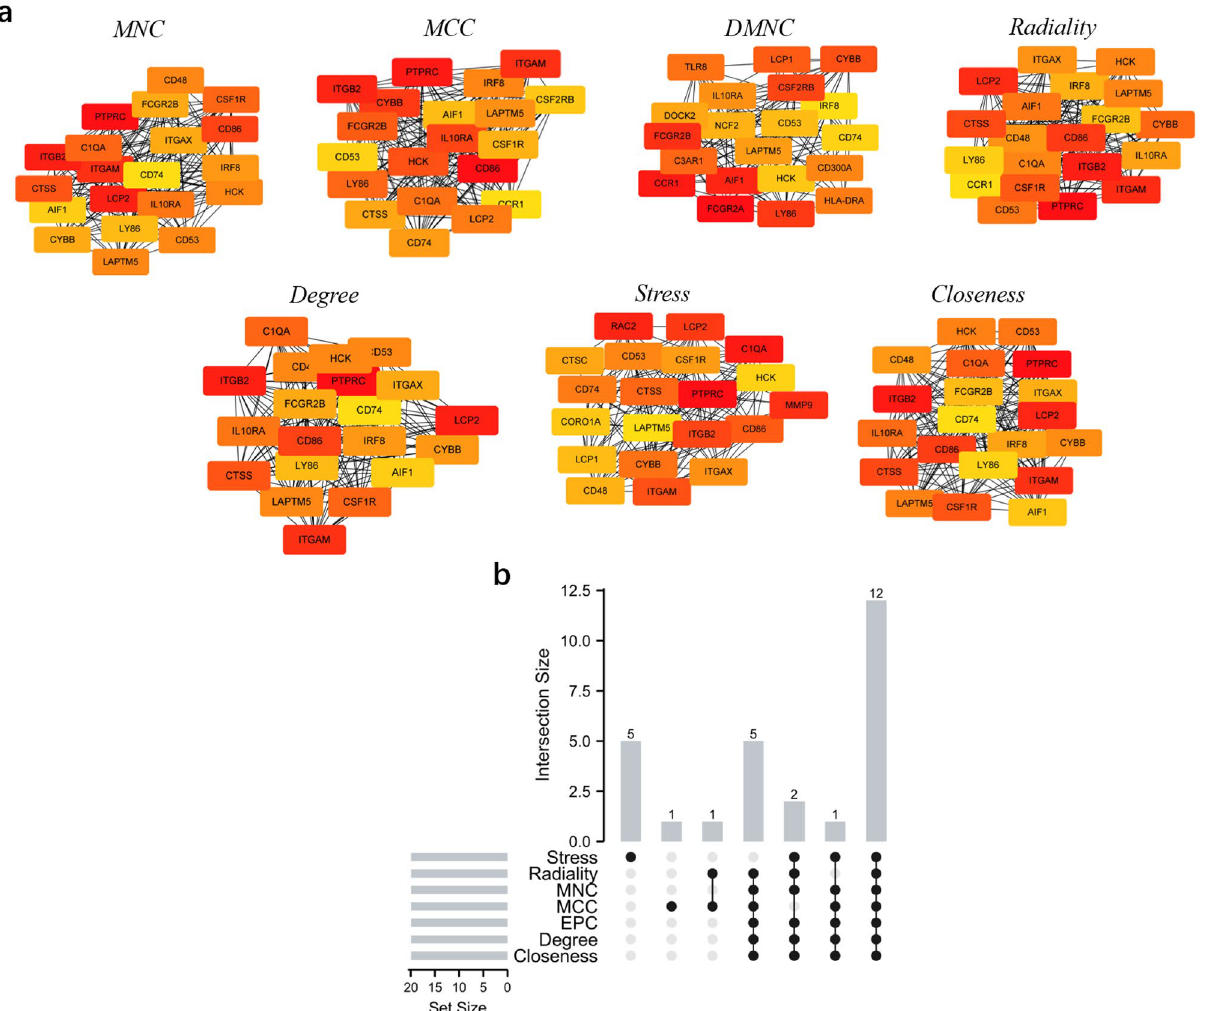
Figure 3. Hub genes identified by different algorithms and UpSet diagram. ( a ) Hub gene identified by seven different algorithms. ( b ) The UpSet diagram showed that the seven algorithms screened 12 overlapping hub